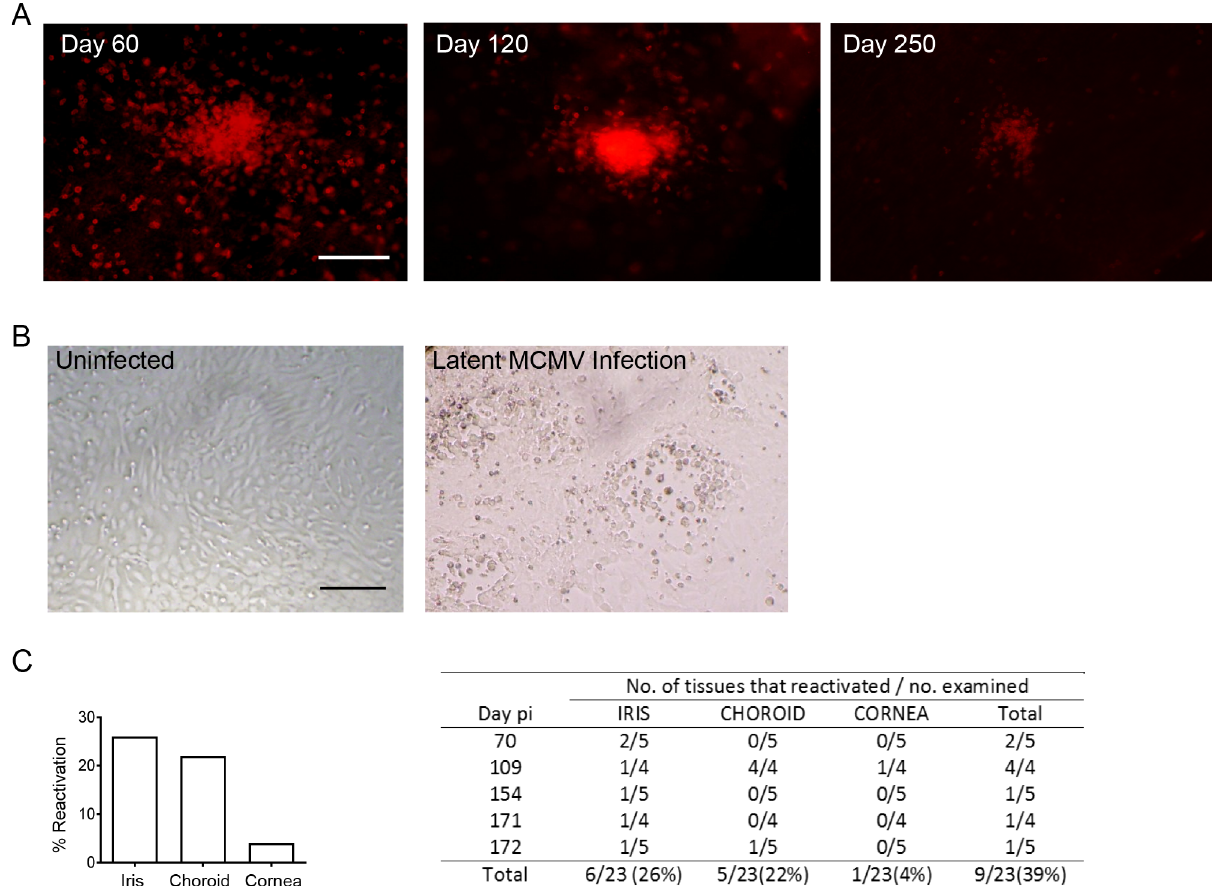
Fig 9. MCMV establishes a latent infection in ocular tissue. (A) At the indicated times pi iris whole-mounts were stained with anti-CD45 antibodies. (B) A representative image of the cellular monolayer of iris explant cultures established from an uninfected mouse (left panel) or a latently infected mouse (right panel). The culture established from a latently infected mouse shows foci of viral replication and cytomegalic cells characteristic of MCMV infection. Scale bar: 200 μ m. (C) Percentage of cultures where MCMV reactivation was detected. (n = 23 mice). The table on the right shows the frequency of viral reactivation in specific compartments of the eye from individual